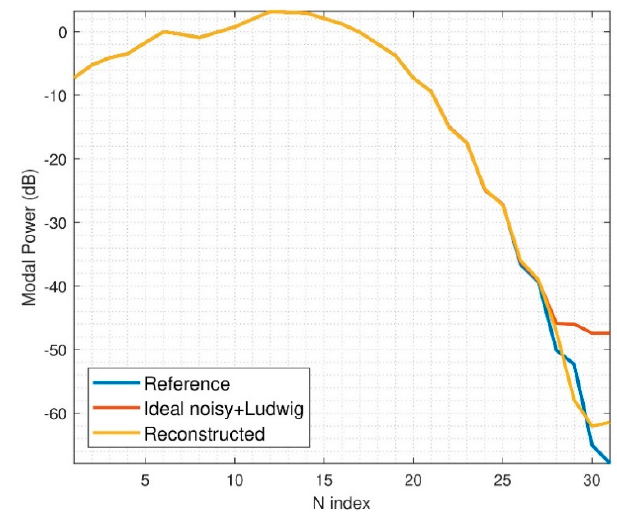
Figure 11. N ‐ power spectrum for noisy simulation, arch rotation of 3.